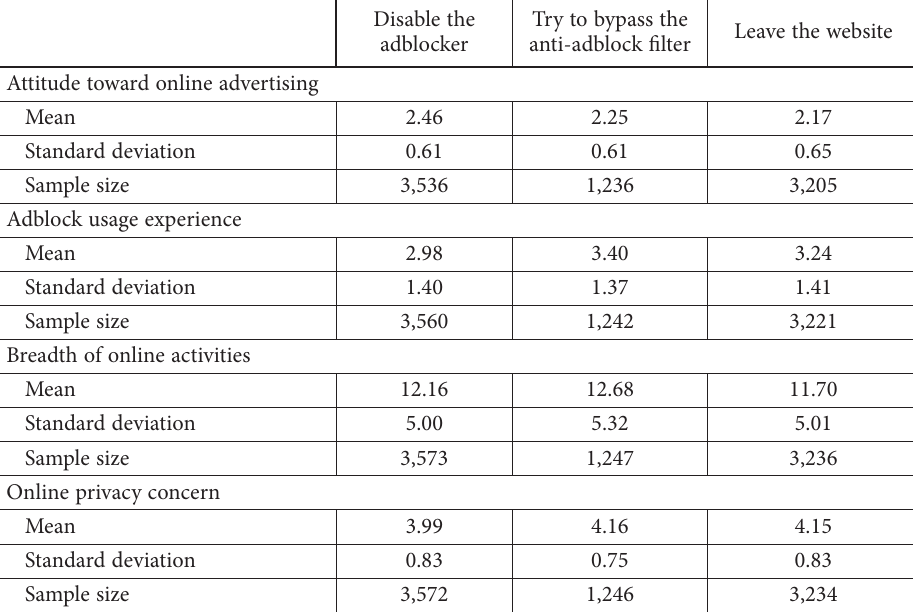
Table 1. Descriptive statistics for responses to anti-adblock filters across predictors